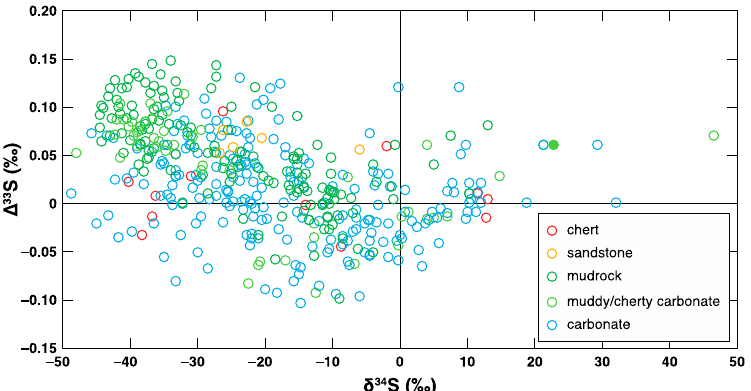
Figure 13. Multiple sulfur isotope records during the Permian-Triassic transition interval. Note that the negative ∆ 33 S signals were detected in various types of sediments.